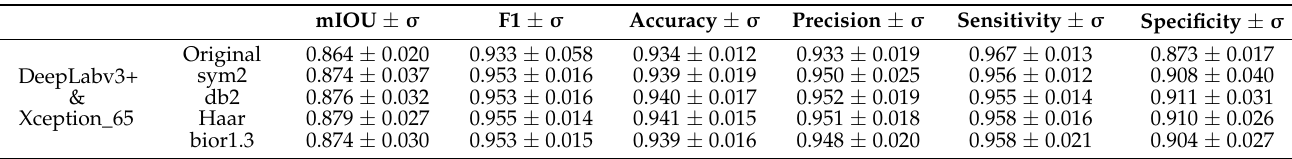
Table 7. Performance of DeepLabv3+ with Xception_65 as backbone trained with data preprocessed with different wavelet functions.